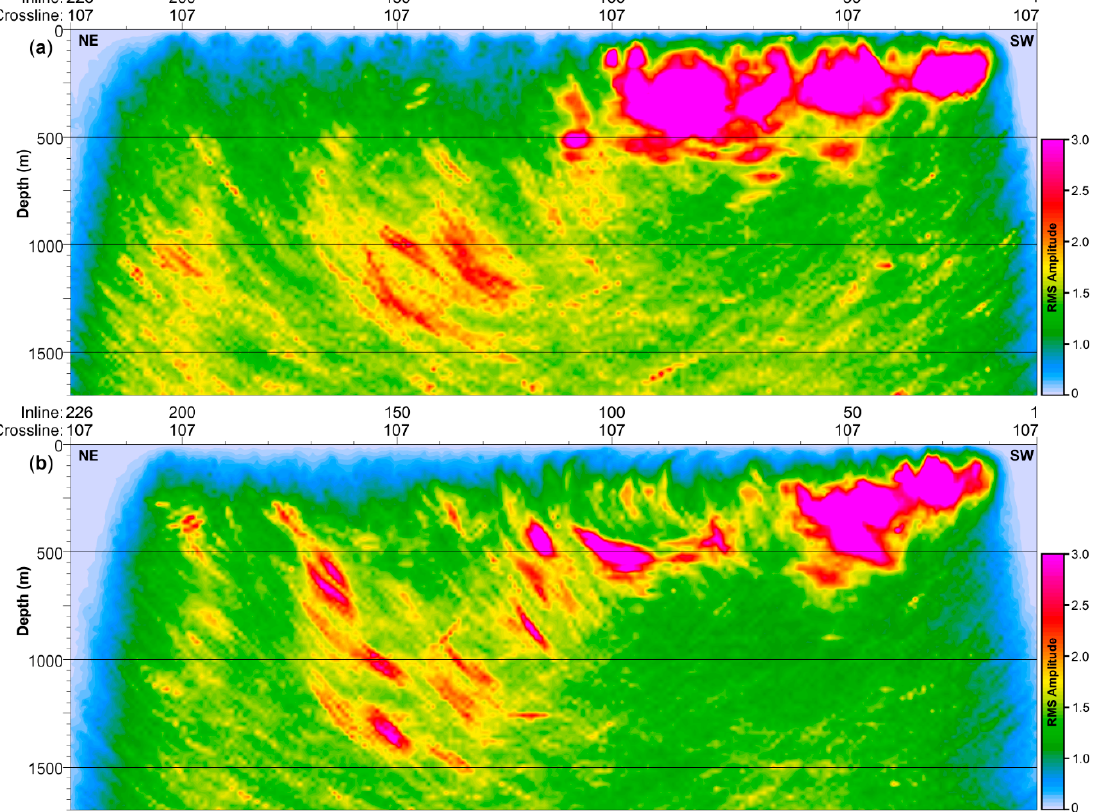
Figure 7. Crossline along the ore zone from the coherency-based Fresnel volume migration (CBFVM) run with 20 m vertical sampling using the velocity model build with ( a ) raw picks; ( b ) picks corrected with refraction statics. A semblance exponent p = 2 was used. Note: the velocity model built from FAT has the uniform sampling of 20 m in each direction.